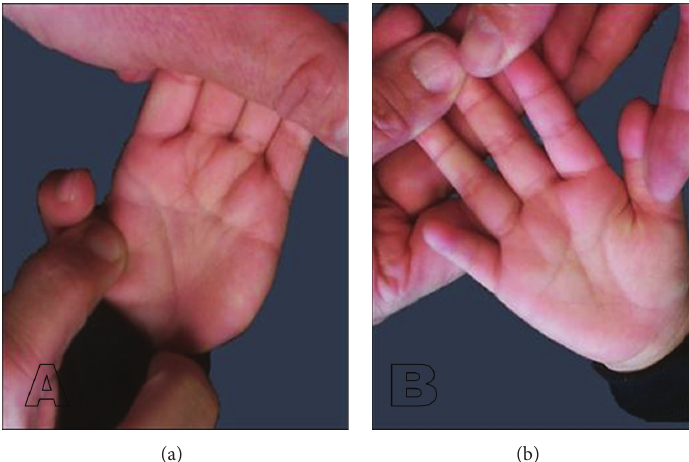
Figure 2: Palmar features. (a) The left palmar creases bridged to form one and distal extends to 2-3 interspace. (b) The right distal palmar crease extends to the 2-3 interspace.